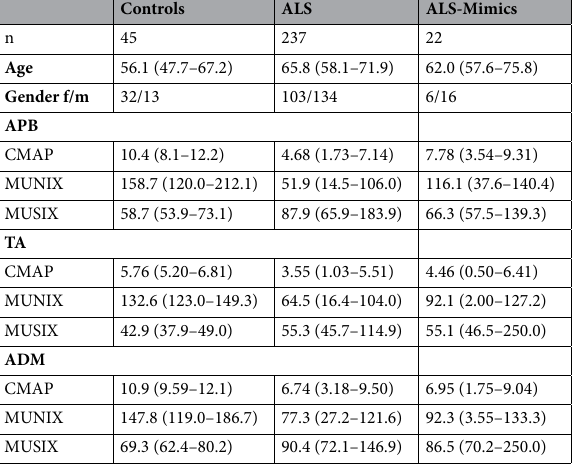
Table 1. The median and percentiles of the controls (Supplementary Table 1) were in accordance with prior studies 26–28 . The controls were slightly younger than the ALS-Mimics (p = 0.047) and the ALS patients (p < 0.001). Gender was also not homogenously distributed over the three groups, there were especially more healthy women in percentage compared to the ALS cohort (p < 0.001). The whole ALS cohort had a D50 median of 29.2 months (IQR 18.5–46.4 months) and a rD50 median of 0.27 (IQR 0.17–0.39). Detailed clinical data for ALS patients are summarized in Table 2. All measurements with a MUNIX value less than 2 or only a CMAP without MUNIX value were set as small values (CMAP = 0.5 mV, MUNIX = 2, MUSIX = 250). The different ALS phenotypes follow the classification of Chio et al. 29 . The category “Pyramidal ALS” denotes a predominant involvement of the upper motor neurons. All ALS patients fulfilled the Gold Coast criteria of ALS 20 . For better comparison with prior studies, Table 2 also shows the classifica- tion according to the revised El Escorial criteria 30 and the disease progression rate calculated as followed: (48 − ALSFRS-R at MUNIX)/disease duration in months. For further analysis, the ALS MUNIX cohort was divided into three subgroups based on disease accumula- tion (rD50) and disease aggressiveness (D50). Stratifying the ALS cohort based on their disease accumulation in three phases of rD50, the D50 medians differed significantly between Phase I and II (p < 0.001). ALS patients